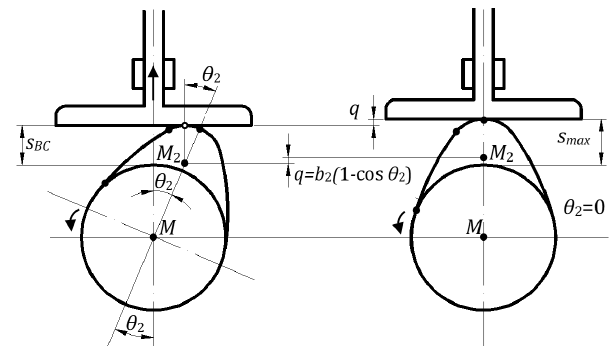
Figure 3. Follower movement on arc-BC.